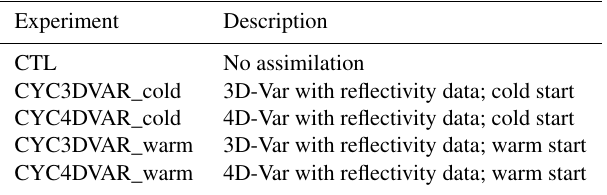
Table 1. Description of the five simulations